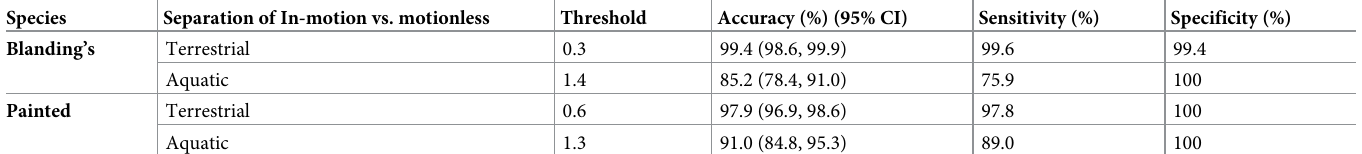
Table 3. Classification performance for the testing data used to classify Blanding’s turtle and Painted turtle activity based on accelerometry data, using the other species’ threshold values. Species Separation of In-motion vs.